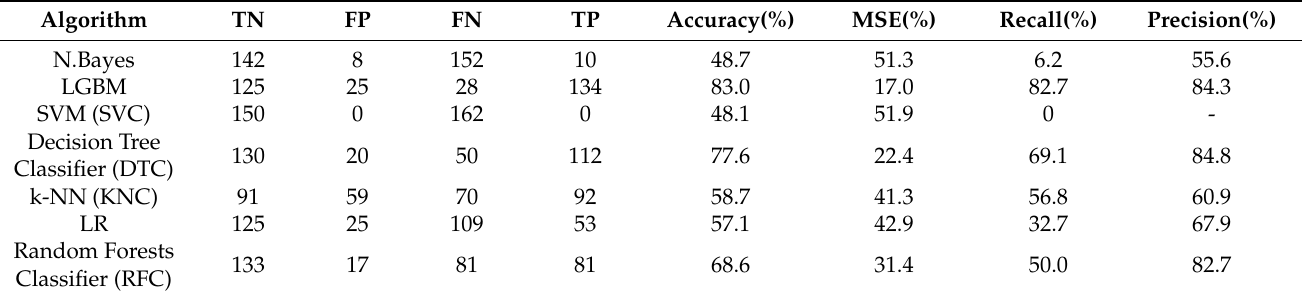
Figure 8. Hearing test results performed with MATLAB GUI hearing test interface. The effects of the sounds from the MATLAB hearing test interface on the brain are recorded with a 16-channel EEG recorder. The obtained performance results are shown in Table 4. ROC curves obtained with seven different classification algorithms using 16 channels of EEG signals are given in Figure 9. The obtained other performance results are shown in Table 5. Table 4. The performance results using 16 channels of EEG signals with machine-learning classifica- tion algorithms.